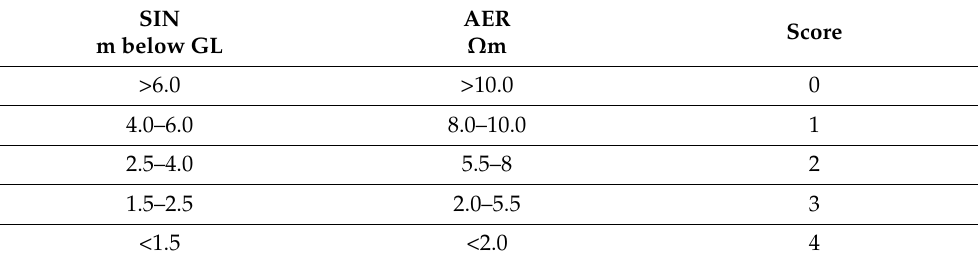
Figure 6. Frequency distribution of the dataset in each hazard layer (i.e., percentage of nodes in each thematic layer class over the total amount of nodes considered in the study area) confined within the minimum and the maximum boundaries set for score 0 and 4, respectively. The acronym GL means ground level. Table 3. Hazard-layer classification: ranges and scores. The values of 0 and 4 mean low and high contribution to vulnerability, respectively.